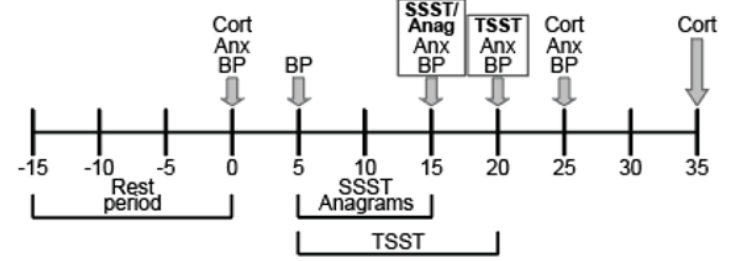
Figure 2. Experimental timeline.